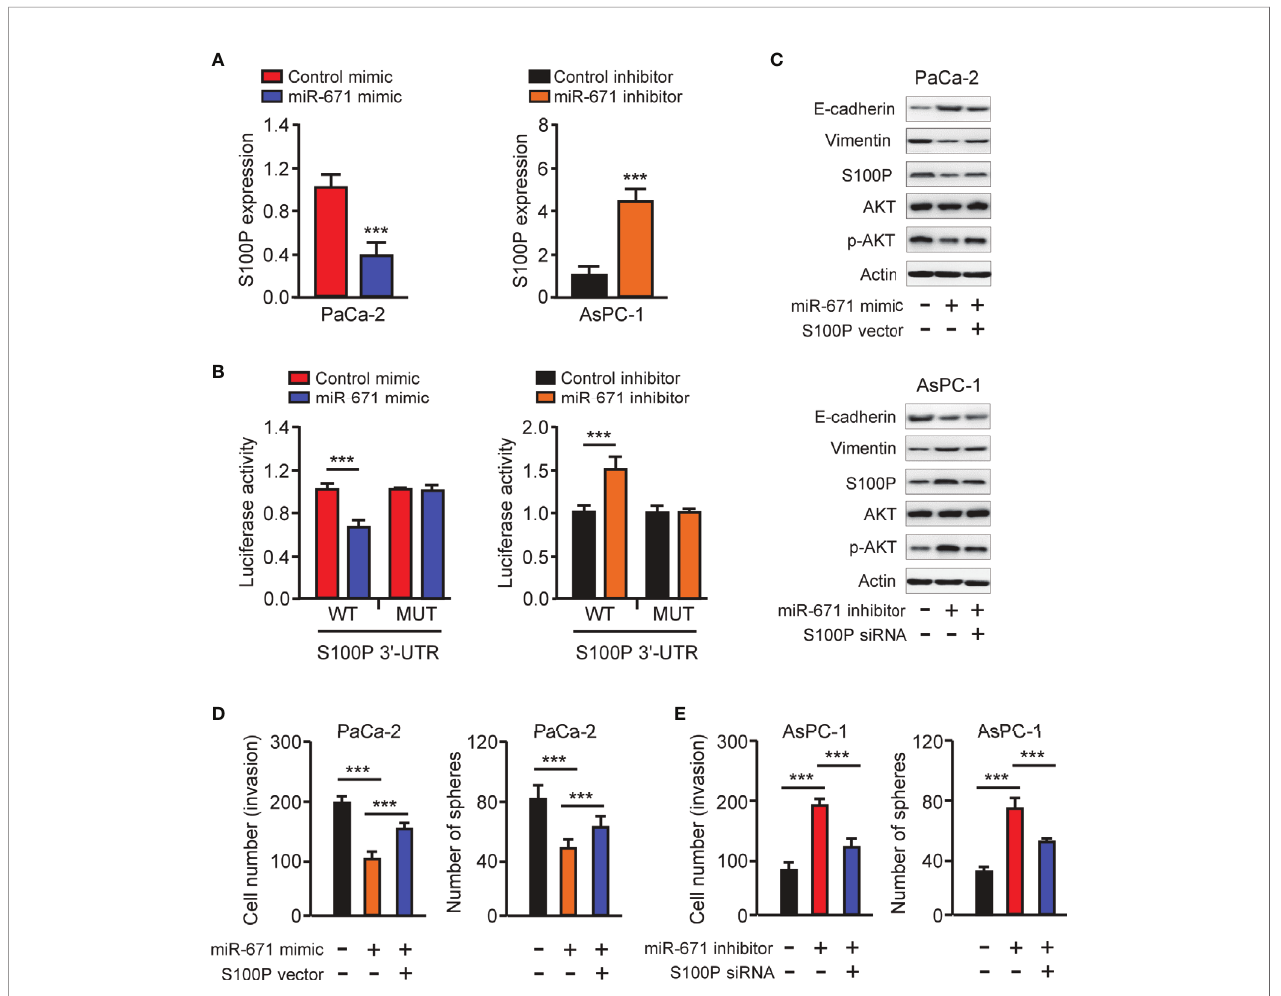
FIGURE 7 | MiR-671 suppresses EMT via targeting S100P. (A) The levels of S100P mRNA in PAAD cells transfected with miR-671 mimic or miR-671 inhibitor, respectively. (B) The activities of S100P 3 ′ -UTR reporter containing WT or MUT miR-671 binding sites were determined using luciferase assay following co-transfection with miR-671 mimic or miR-671 inhibitor. (C) Western blotting analysis of the indicated proteins in PAAD cells transfected as indicated. (D, E) Cell invasion assay (left) and tumor sphere formation assay (right) in PaCa-2 cells transfected with (or without) miR-671 mimic, with (or without) S100P expression vector (D) , and in AsPC-1 cells transfected with (or without) miR-671 inhibitor, with (or without) S100P siRNA (E) . *** P